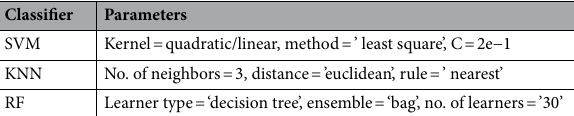
Table 3. Parameters used in the